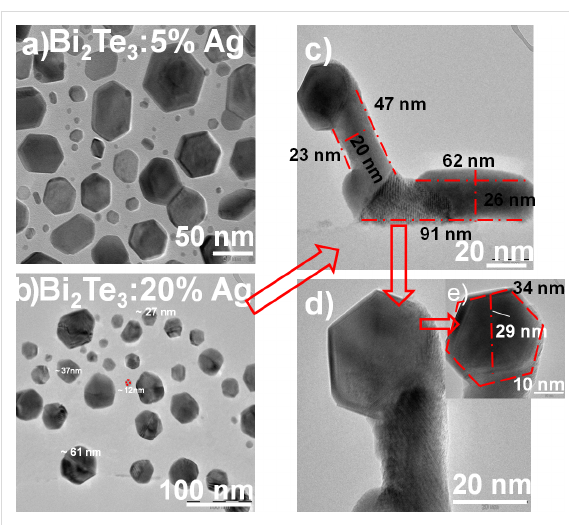
Figure 4: TEM of Bi 2 Te 3 with (a) 5% and (b) 20% Ag annealed at 773 K, (c, d, e) HRTEM images of Bi 2 Te 3 with 20% Ag annealed at 773 K.